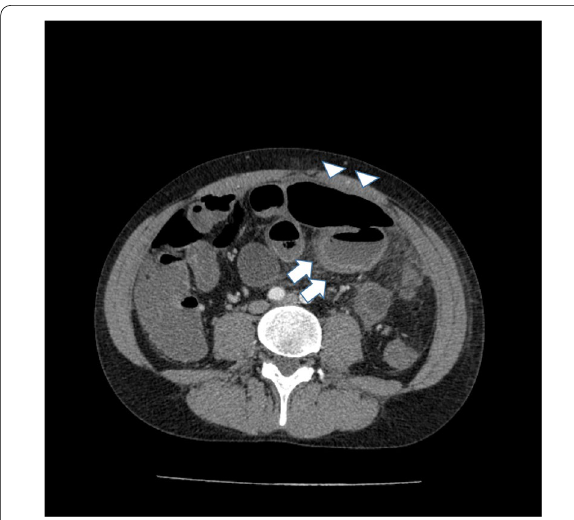
Fig. 1 Abdominal computed tomography findings on the third day after patient admission to the hospital for abdominal pain. Wall thickening and thinning of the sigmoid colon (white arrows) and free gas in the abdominal cavity (white triangles) are observed